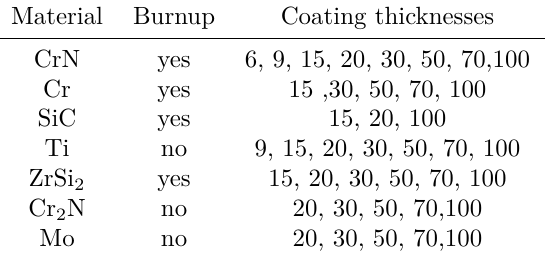
Table 5. Coating material and tested parameters.